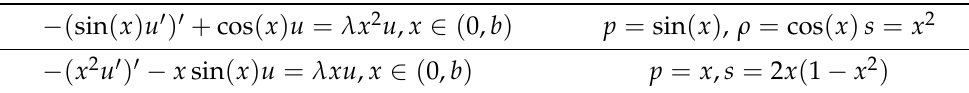
Table 3. Examples of Sturm–Liouville